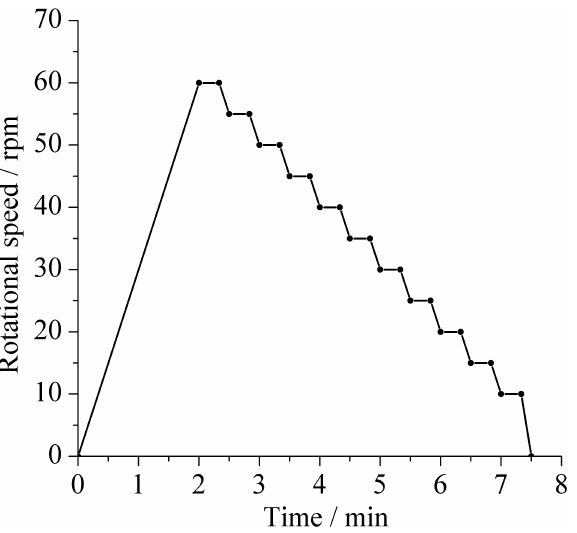
Figure 1. The rheological scheme for measurement of rheological parameters of pastes.